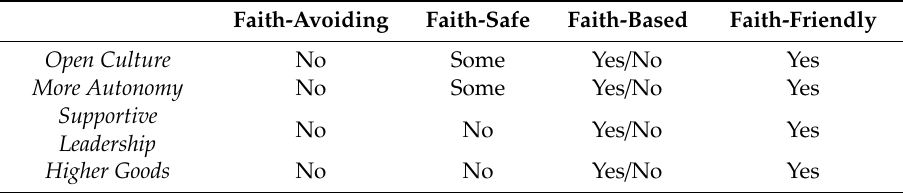
Table 6. Application of Miller and Ewest’s (2015) framework to global themes. Faith-Avoiding Faith-Safe Faith-Based